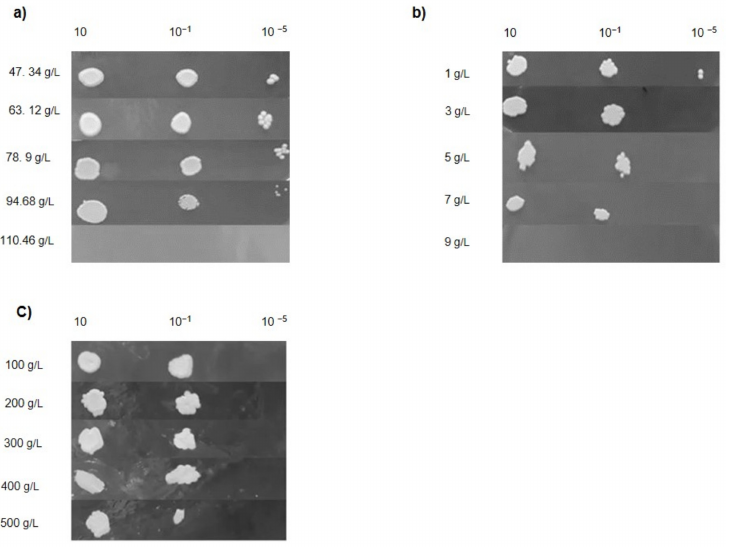
Figure 2. Effect of ( a ) ethanol, ( b ) acetic acid, and ( c ) glucose concentrations on cell growth of P. kudriavzevii